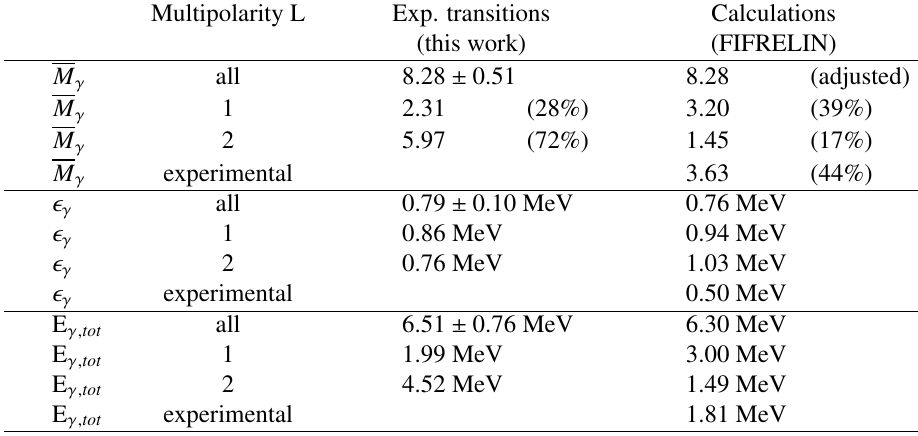
Table 1. Prompt γ -ray characteristics for the spontaneous fission of 252 Cf. Experimental results from this work for the average γ -ray multiplicity M γ , the average energy per photon (cid:15) γ , and the total energy E γ, tot released in fission, are given for the integral spectrum as well as for the multipolarity-dependent spectra and compared to corresponding values recently calculated with FIFRELIN [22] (see text for details). Relative multiplicities are also given, under the assumption that higher multipolarities may be